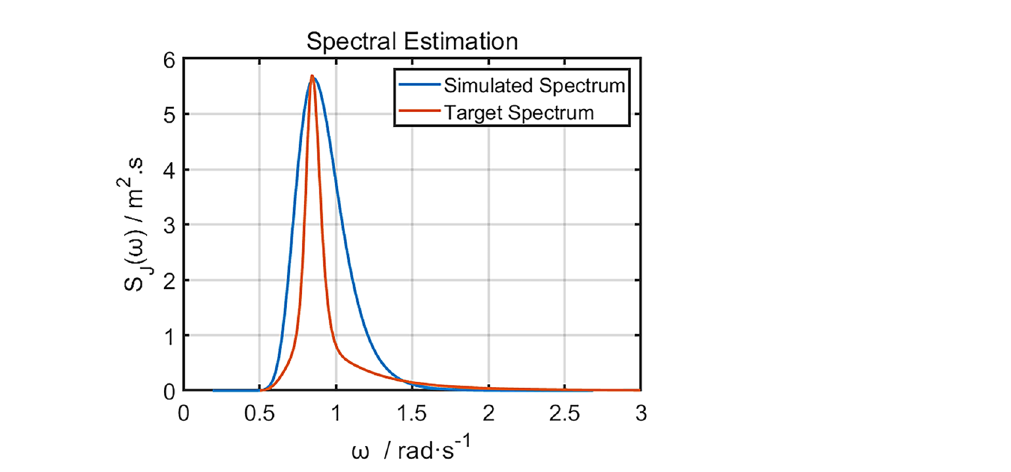
FIGURE 9 | Comparison of the simulated wave spectrum with the target